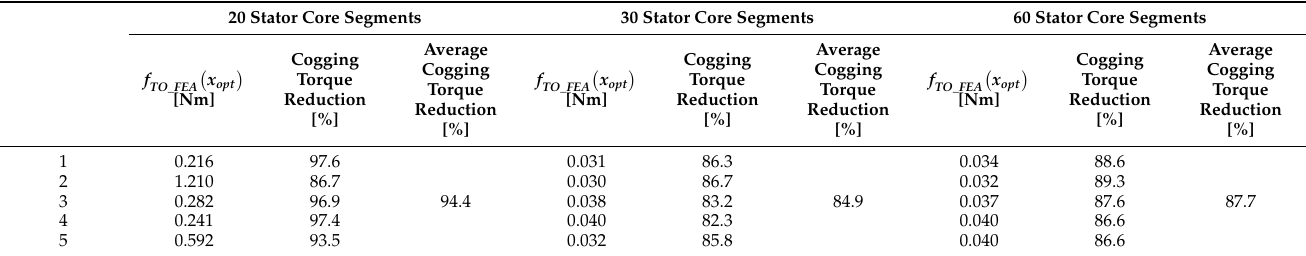
Table 5. Results of the optimizations with the proposed heuristic